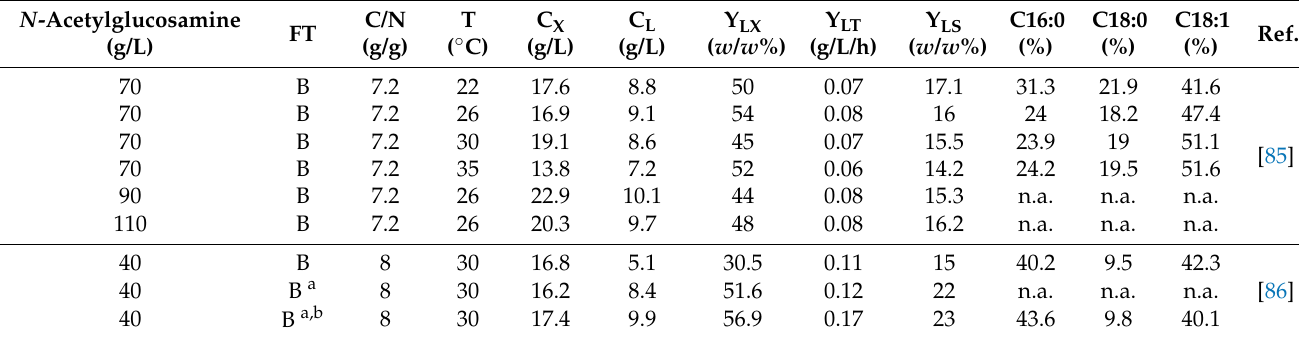
Table 4. Bioconversion of N -acetylglucosamine to single-cell oil by the biocatalyst C. oleaginosus at pH 5.5. N -Acetylglucosamine (g/L)